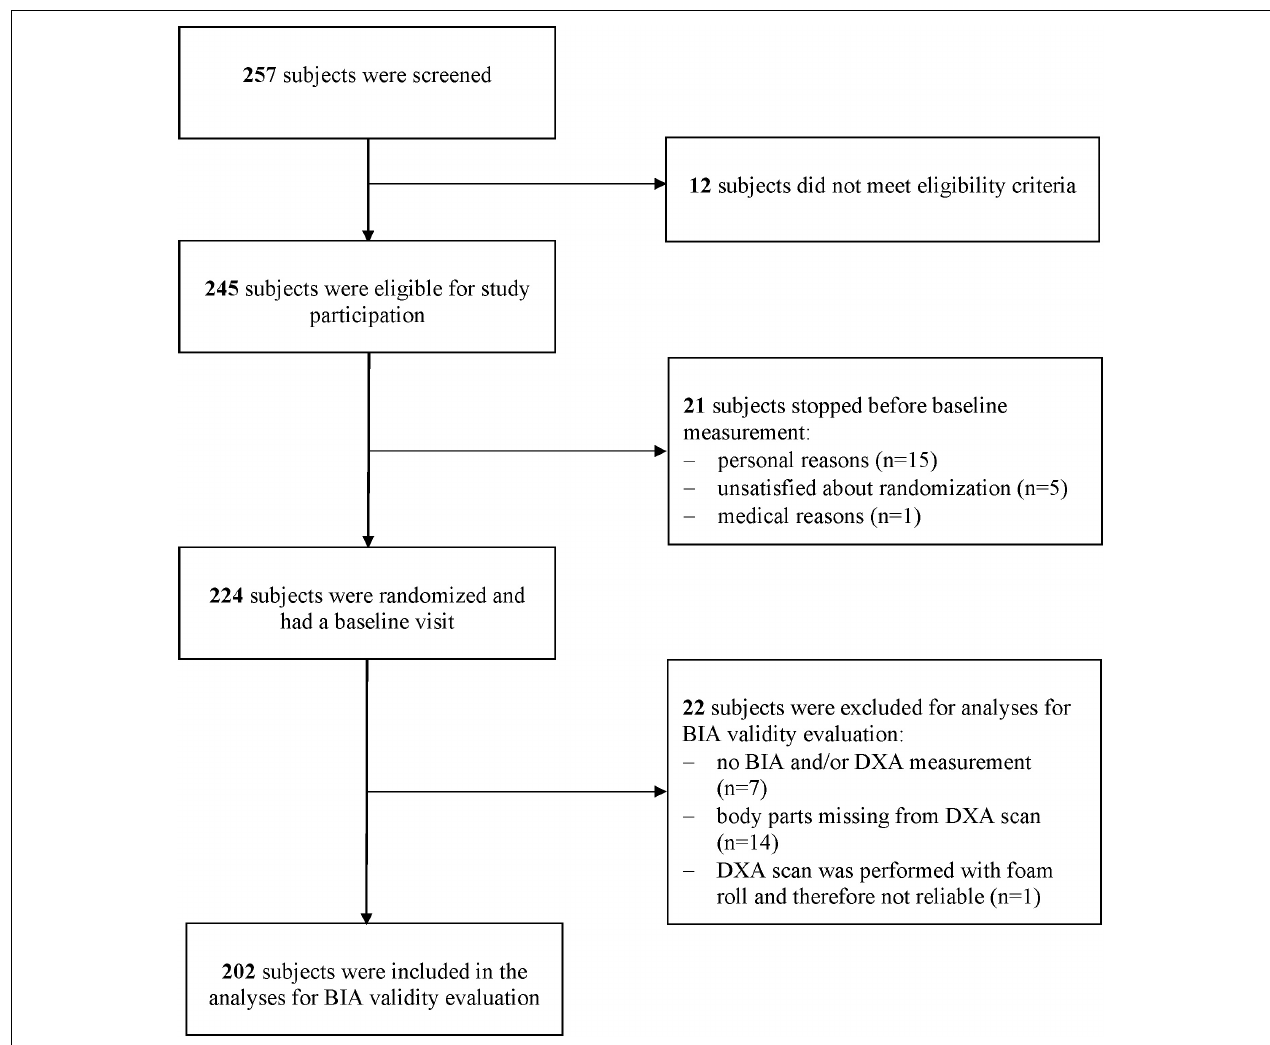
FIGURE 1 | Flow chart of participants for the inclusion in the analysis for BIA validity evaluation.